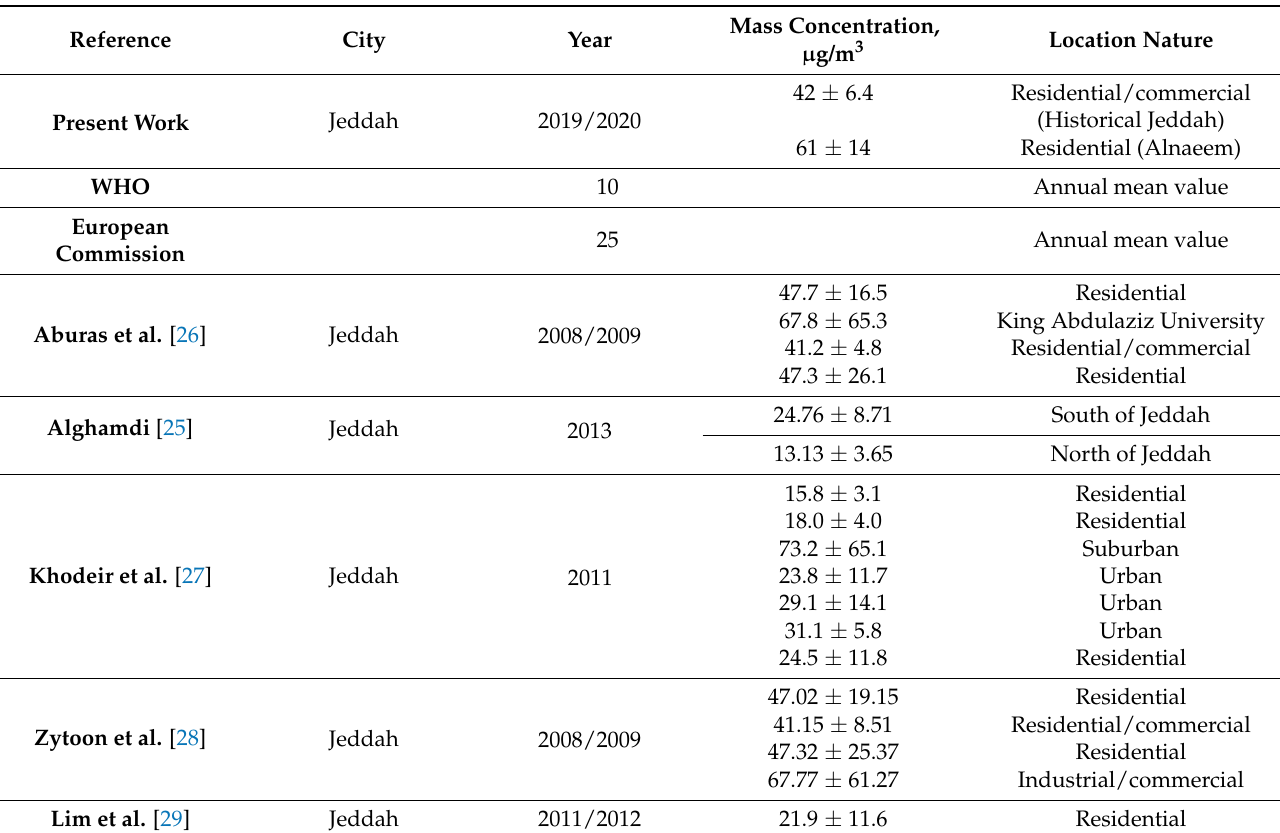
Table 1. The average mass concentration of the PM 2.5 samples reported in the present work and in the previous published works in Jeddah, Saudi